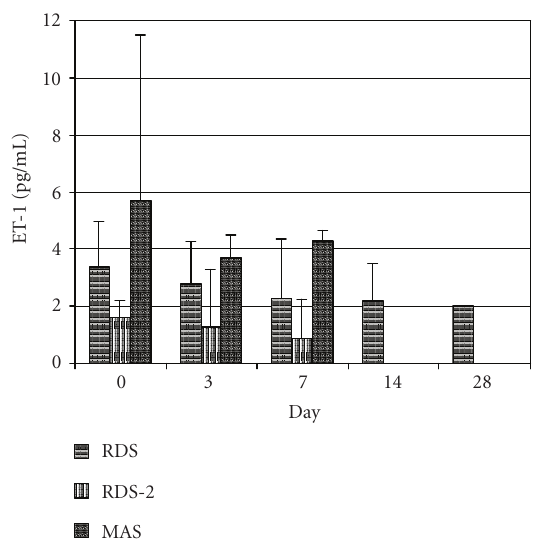
Figure 3: Changes of the plasma ET-1 (pg/mL) concentrations dur- ing the oxygen treatment days in the di ff erent dignostic newborns tended to decrease. The plasma ET-1 concentrations in the sixth hour of life were decreased at third day as 2 . 80 ± 1 . 49pg/mL in RDS, 1 . 28 ± 0 . 84pg/mL in RDS-2, and 3 . 69 ± 2 . 13pg/mL in MAS group. This values also was significantly di ff erent as ( P < . 05). Values at the seventh and simultaneous days were also